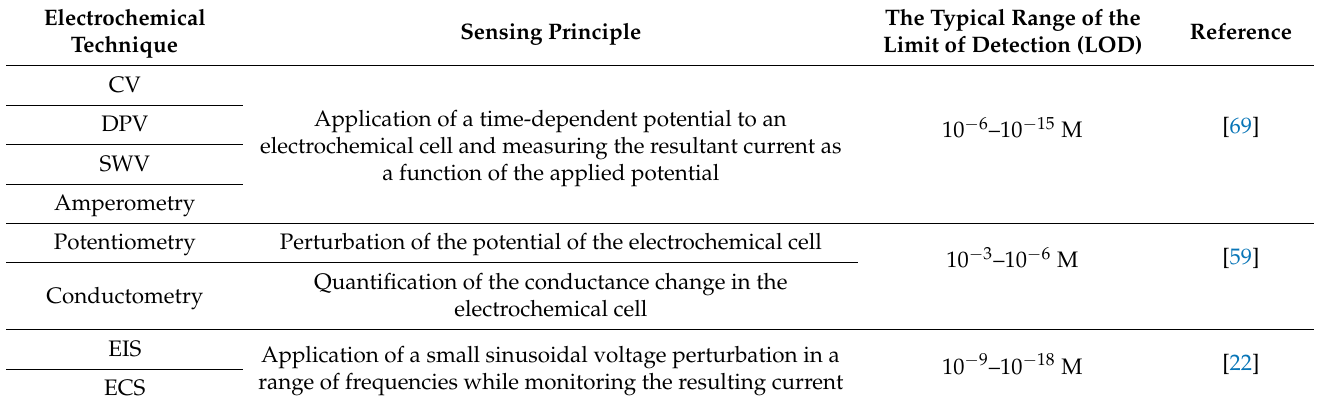
Table 1. Table of electrochemical glycobiosensors and analytical performance.